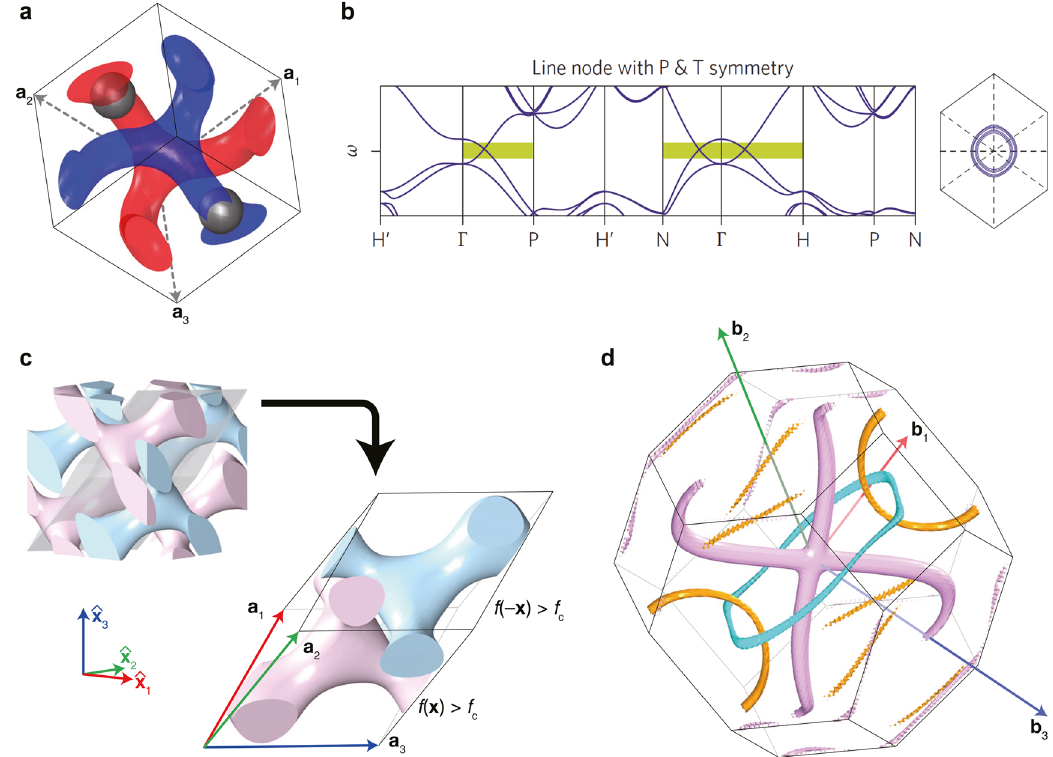
Figure 6: Examples of nodal lines in dielectric photonic crystals. (a) Inversion symmetric double gyroid structure that has air spheres. (b) Band structure of (a) that exhibits a nodal ring in the momentum space. (c) Inversion symmetric and anisotropic double diamond structure. (d) Nodal link, nodal chain, and nodal lines in momentum space of the structure in (c). Reproduced with permission from Reference [7]. Copyright 2013, Nature Portfolio (b); reproduced with permission from Reference [18]. Copyright 2021, American Chemical Society (c) and